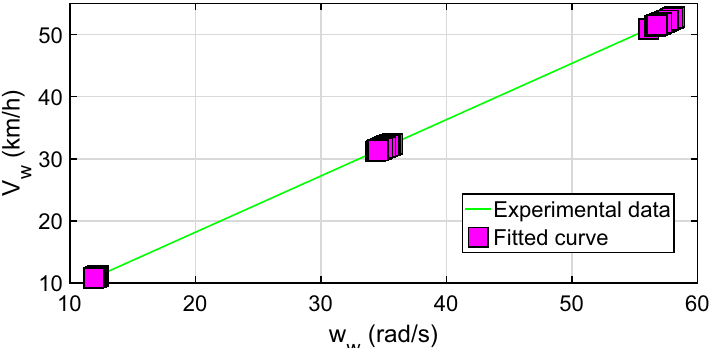
Figure 14. Relationship between tire speed, V w , and rotation speed, ω w , calculated through the methodology proposed in the experimental